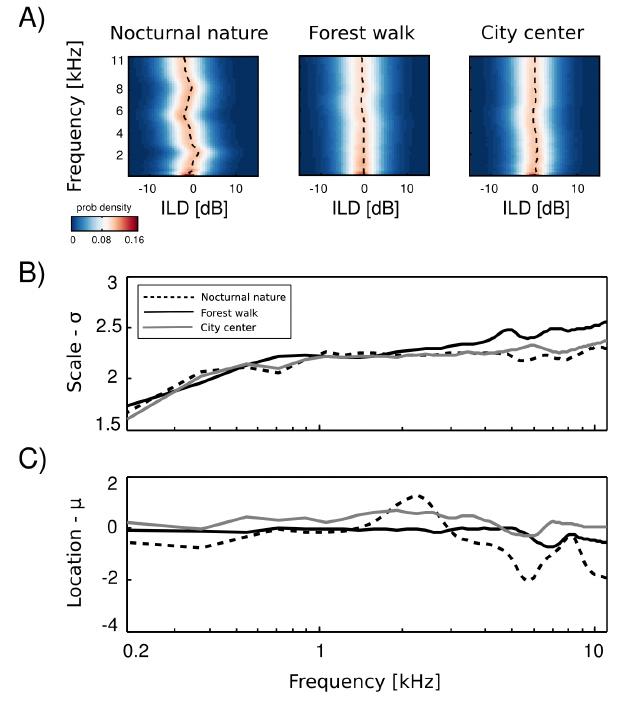
Figure 4. Interaural level difference distributions. A) Histograms plotted as a function of frequency - a strong homogeneity of distributions is visible across recorded scenes and frequency channels. B) The scale parameter s v of fitted logistic distributions plotted as a function of frequency C) The location parameter m v plotted as a function of